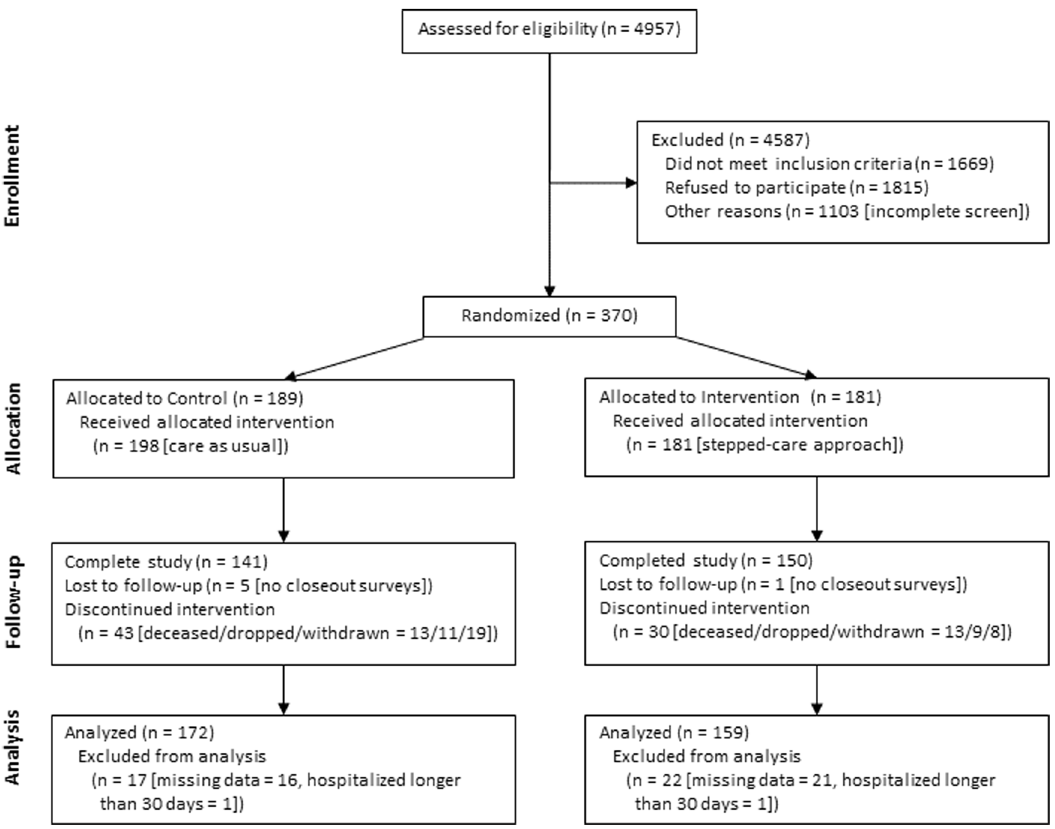
Fig. 1 Participant fl owchart. Summarizes the recruitment, randomization, and retention fl ow of patients in this study, leading to the fi nal analyzed